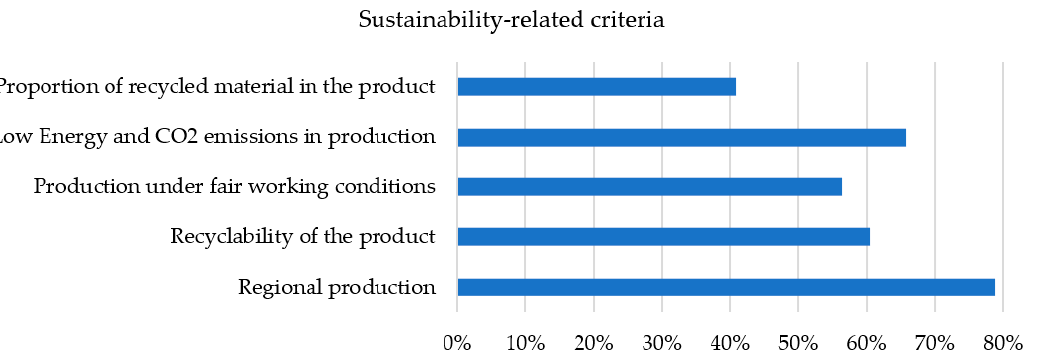
Figure 6. Relevant sustainability-related criteria when making purchasing decision.